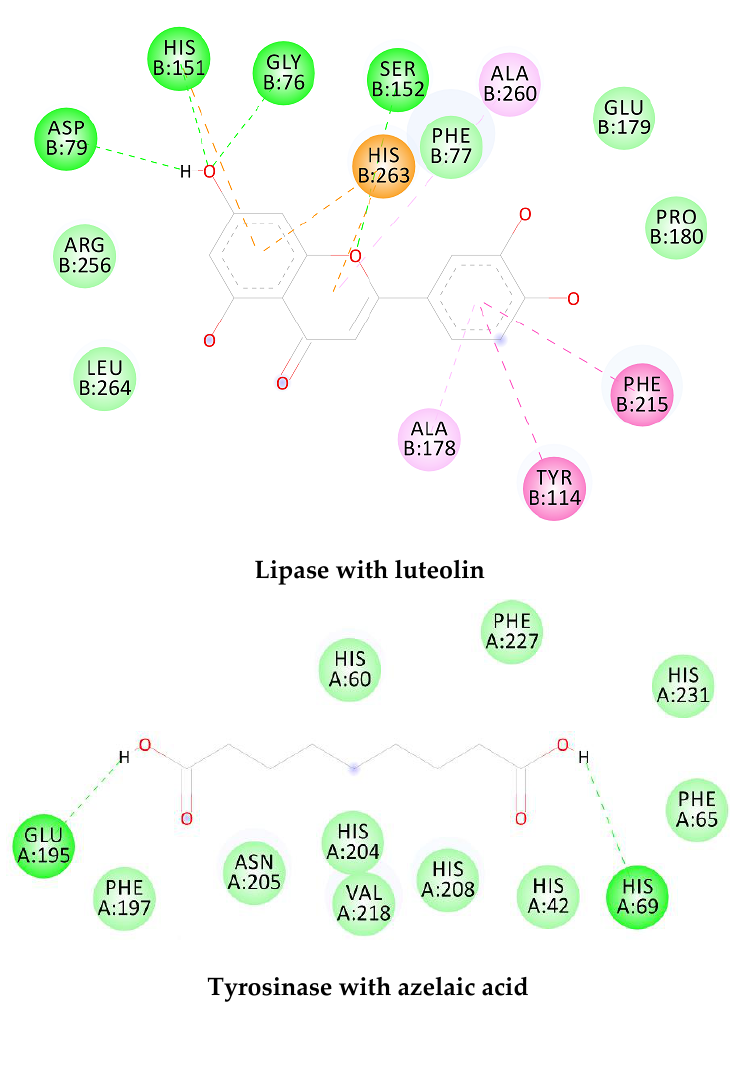
Figure 4. Enzyme-substrate interactions of luteolin and azelaic acid with lipase and tyrosinase enzymes, respectively.